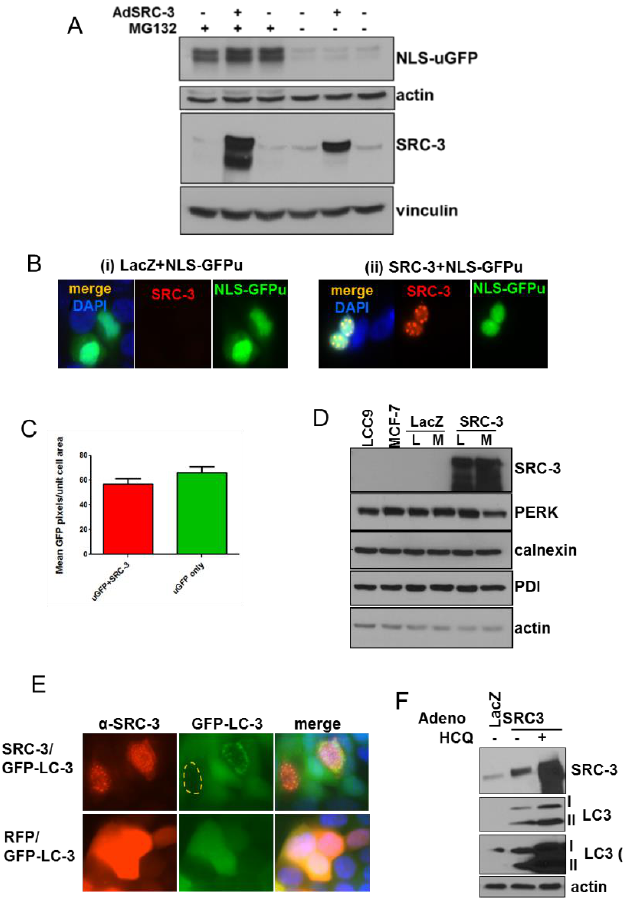
Figure 4. SRC-3 overexpression induces autophagy but does not affect the proteasome . ( A ) MCF-7 cells stably transfected with a nuclear-targeted GFP (NLS-GFPu) were mock-infected, or infected with Ad-SRC-3 or Ad-Lac-Z. Cells harvested 72 h after infection with or without 10 µ M MG132 for the final 3 h of culture. Immunoblots were probed with anti-GFP and anti-SRC-3. Anti-actin reactivity was used as a control for protein loading on anti-GFP-probed blots. E-cadherin or vinculin were used as loading controls for blots probed with anti-SRC-3. ( B ) Cells infected as in A were seeded on coverslips and IF was performed after 72 h. GFP (green), anti-SRC-3/CY5 (red) and DAPI fluorescence are shown (63 × magnification). ( C ) Graph depicting average of uGFP pixels / nuclear area within nuclei of MCF-7 cells described as above in A . Bars are S.E.M. ( D ) Immunoblots to detect the activation of the unfolded-protein response in LCC9 (L) (a tamoxifen-resistant MCF-7 derivative [30]) and MCF-7 (M) cells uninfected or infected with adenoviral (Ad)-LacZ or Ad-SRC-3. Actin reactivity serves as a protein loading control. ( E ) MCF-7 cells stably expressing LC3-EGFP were infected with Ad-SRC-3 or Ad-RFP. Anti-SRC-3 and GFP-LC-3 were detected by epifluorescence microscopy (63 × magnification). ( F ) MCF-7 cells were infected with Ad-Lac Z or Ad-SRC-3 and treated with a vehicle or 20 µ M HCQ for 48 hrs. Lysates were immunoblotted for SRC-3, LC3 or actin, (LE denotes long exposure).